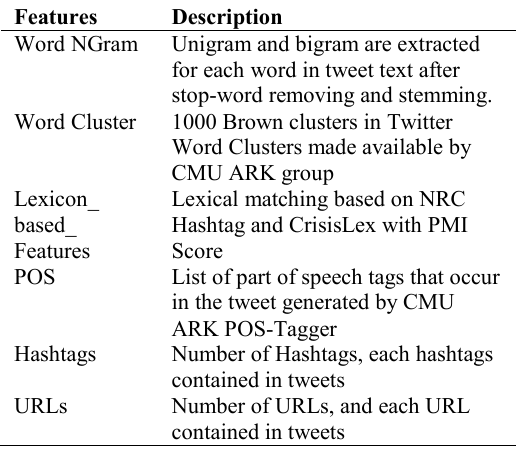
Table 1. Features used in the proposed system